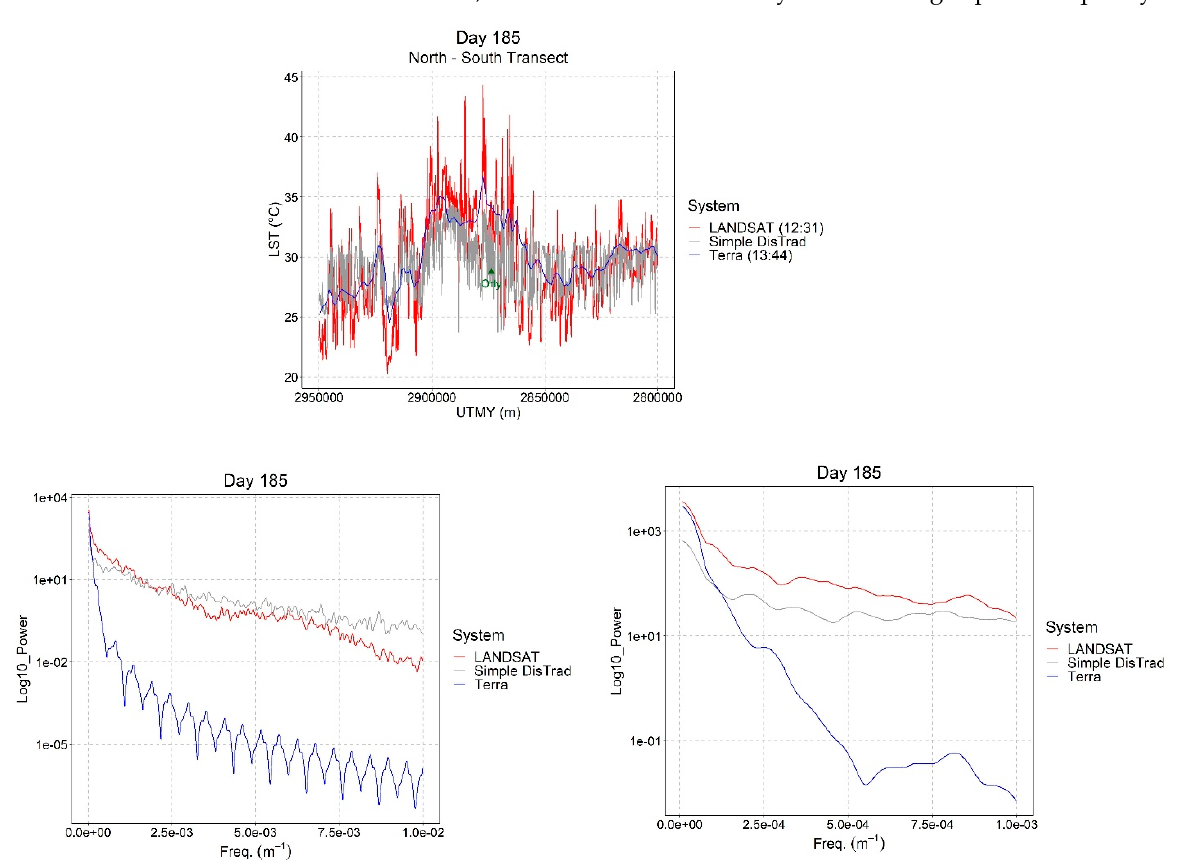
Figure 7. A comparison of a N–S transect through Orly Airport ( top ) and the equivalent spatial power spectra in its entirety ( bottom left ) and in detail ( bottom-right ) of LANDSAT, TERRA and simple DisTrad LST